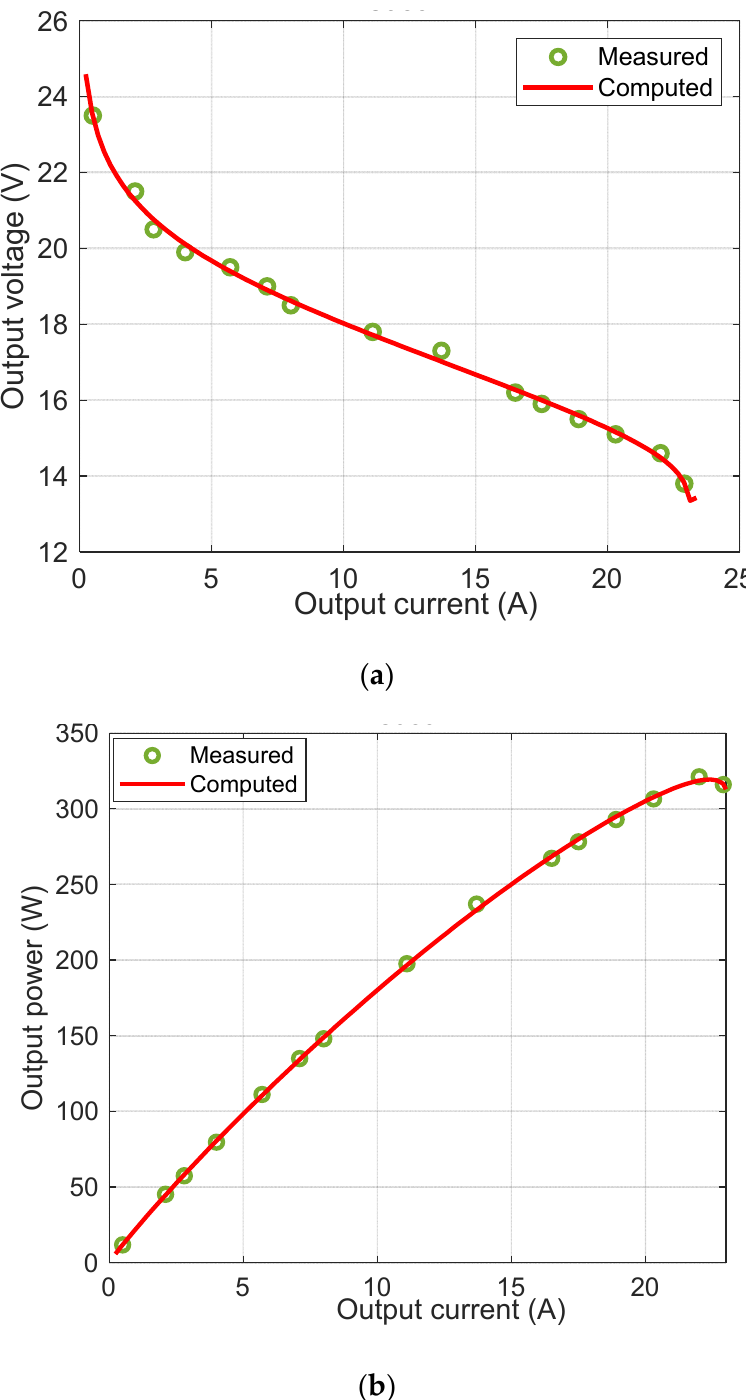
Figure 14. Characteristics of 250 W stack: ( a ) current-voltage and ( b ) current-power.